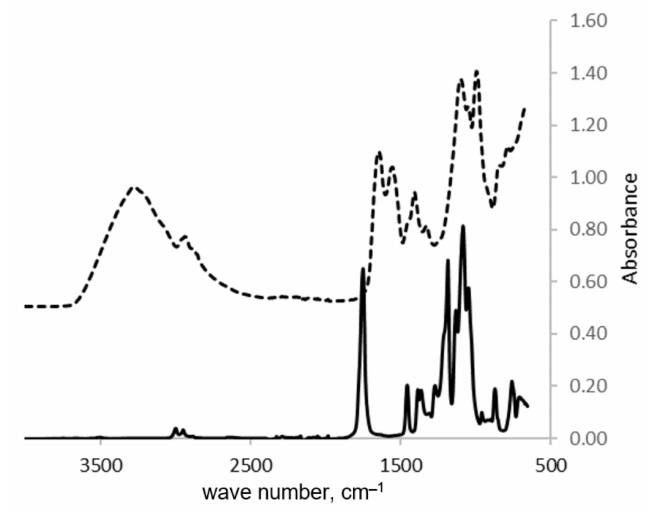
Figure 1. FT-IR-ATR spectra of the two surfaces of the 50:50 CSM:PLA bilayer film. Top spectrum is for the CSM surface, the bottom spectrum for the PLA